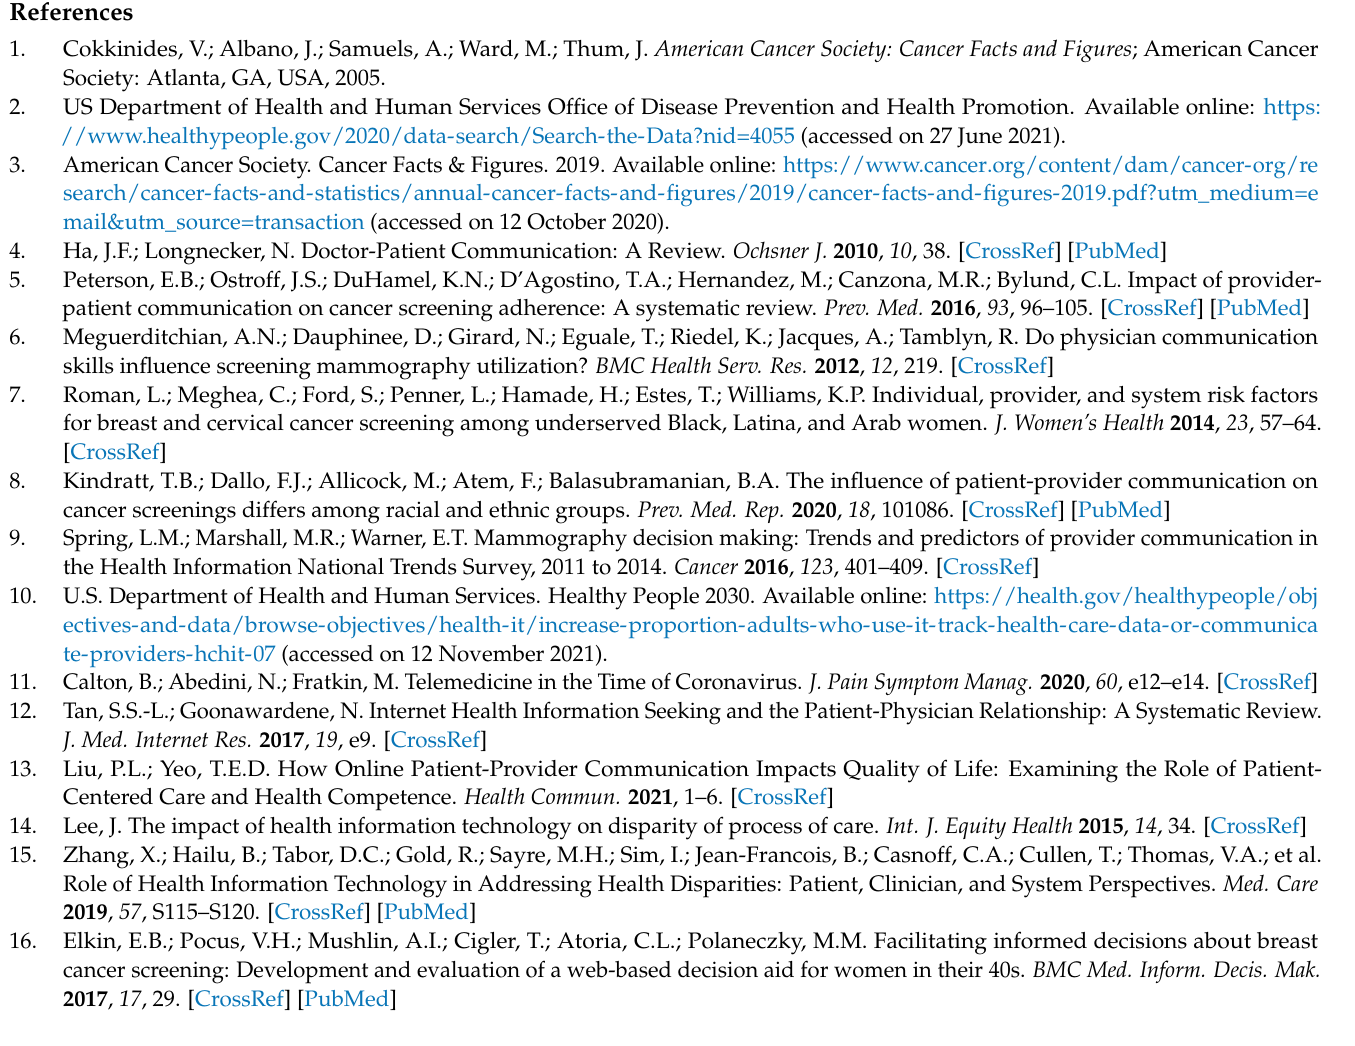
Table S12: Odds ratio and 95% CI based on multiple logistic regression for all years combined (2011–2018) showing all covariates (n = 94,290). Adjusted model 1 a